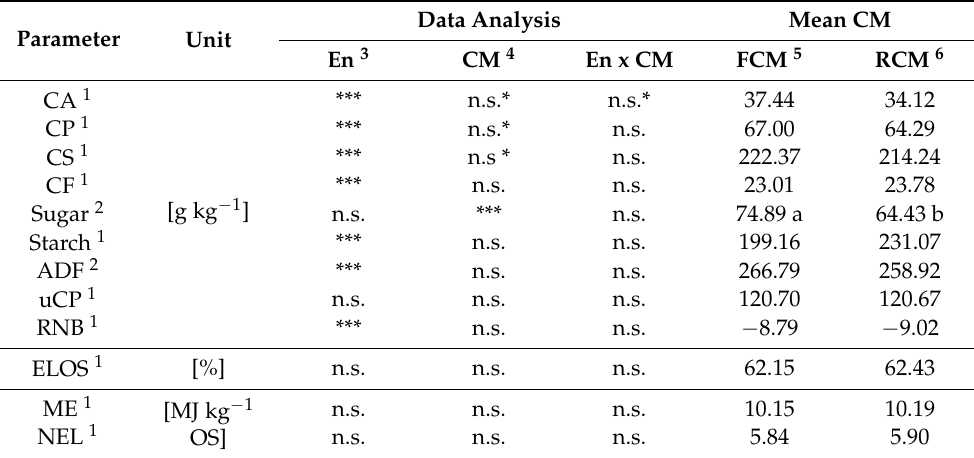
Table 6. Results of a multiple comparison statistical analysis of maize fodder nutrient content. -Environment x Cultivation method, n.s.—not significant, n.s.*—not significant, but tends to be signif- icant, ***—significance. Arithmetic means of all Environments. Eight replications in Enrivonments Bösenbrunn 2017 (BB17) and Oberhermsgrün 2018 (OG18). Four replications in Environment Bergen 2020 (BR20). Different letters indicate significance at p <